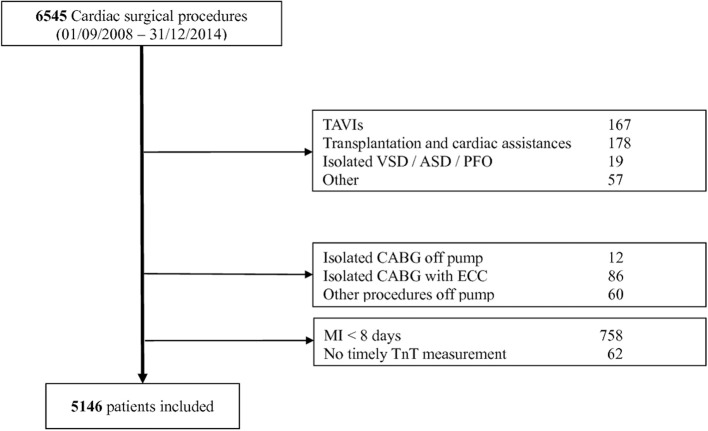
Flowchart of patients' selection.